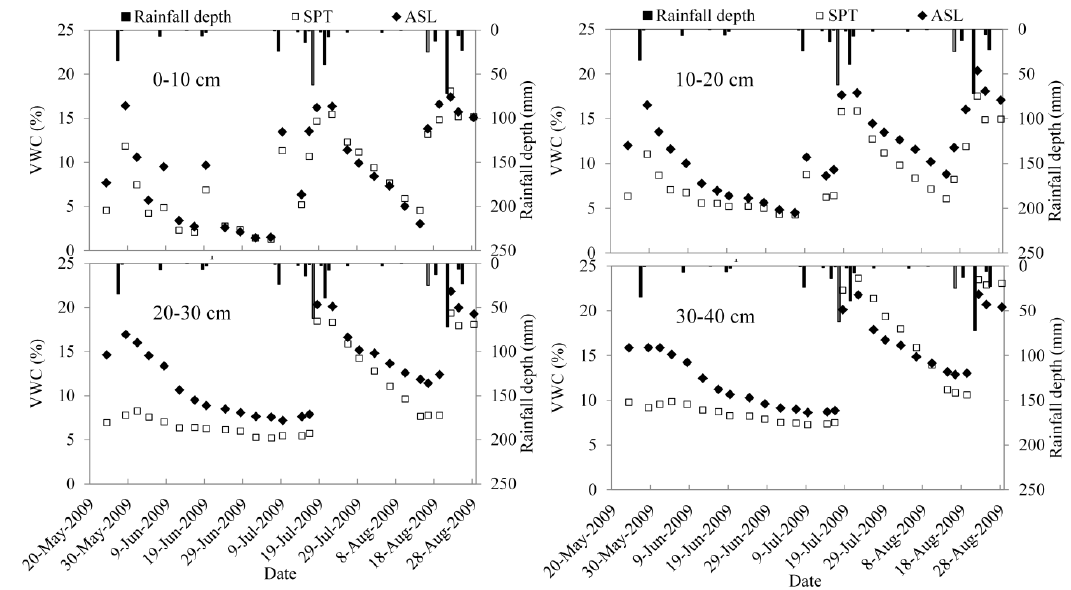
Figure 7. Evolution of mean soil moisture at the two sites.